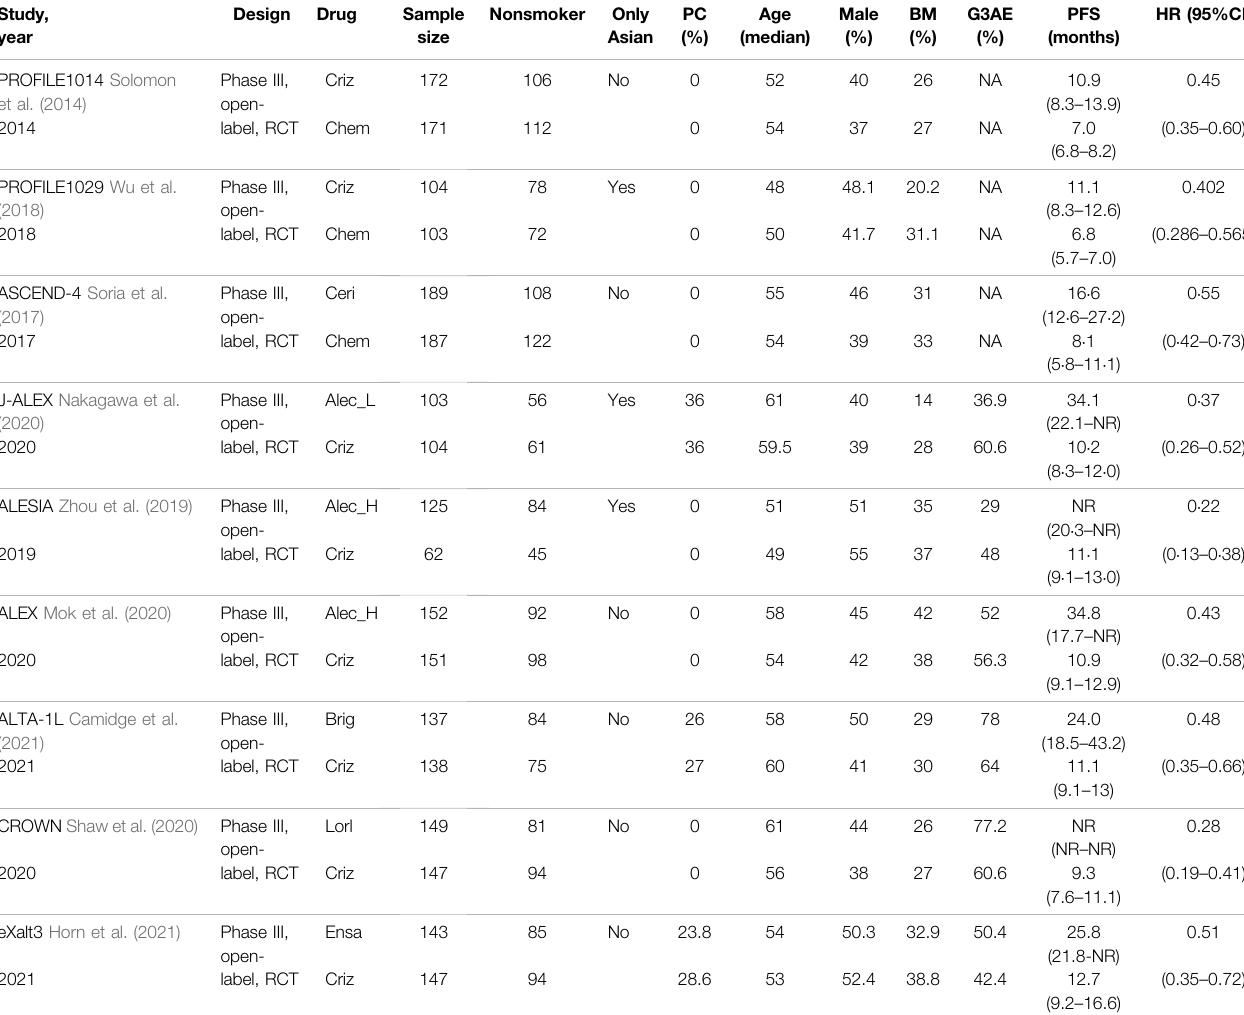
TABLE 1 | Characteristics of the included studies of fi rst-line ALK-TKI treatment for advanced ALK-positive NSCLC. Study,